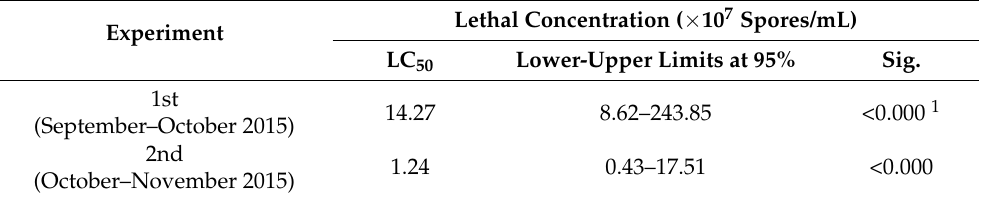
Figure 3. Chili thrips populations on chili plants during the determination of P. lilacinum TBRC10638 LC 50 values performed in the greenhouse. ( A ). Experiment 1 (September–October 2015), ( B ). Experi- ment 2 (October–November 2015). Table 4. Estimated lethal concentration values (spores/mL) of P. lilacinum TBRC10638 against chili thrips ( S. dorsalis ) in the